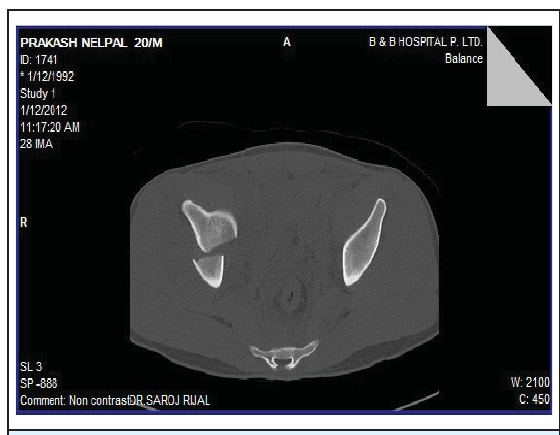
Figure 1. 20 Y/M Axial CT image demonstrates bicol- umn fracture of right acetabulum.